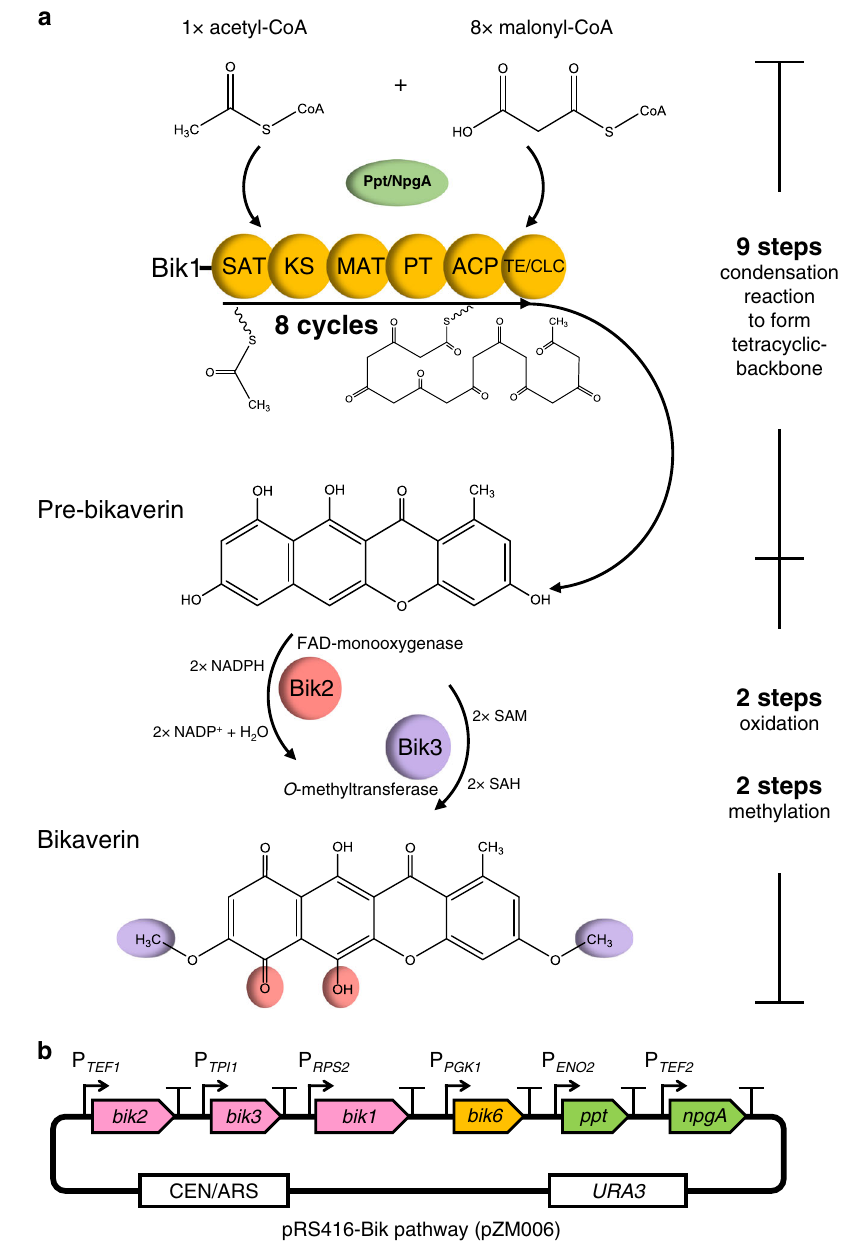
Fig. 1 Bikaverin biosynthetic pathway in S. cerevisiae . a In the bikaverin biosynthetic pathway, the polyketide synthase Bik1, activated by phosphopantetheinyl transferase (PPTase), condenses one acetyl-CoA and eight malonyl-CoA units to form pre-bikaverin. The modifying enzymes Bik2 (monooxygenase) and Bik3 ( O -methyl-transferase) convert pre-bikaverin into the fi nal product bikaverin. The groups modi fi ed by Bik2 or Bik3 are highlighted in red or purple, respectively. SAT, starter unit acyltransferase; KS, ketosynthase; MAT, malonyl:ACP acyltransferase; PT, product template; ACP, acyl carrier protein; TE/CLC, thioesterase/claisen cyclase; SAM, S-adenosylmethionine; SAH, S-adenosylhomocysteine. b The constructed bikaverin pathway encoding plasmid. The ppt1 , npgA , and bik genes ( bik1 , bik2 , bik3 , bik6 ) were codon-optimized, synthesized, and assembled into the pRS416 plasmid vector and transformed into S. cerevisiae